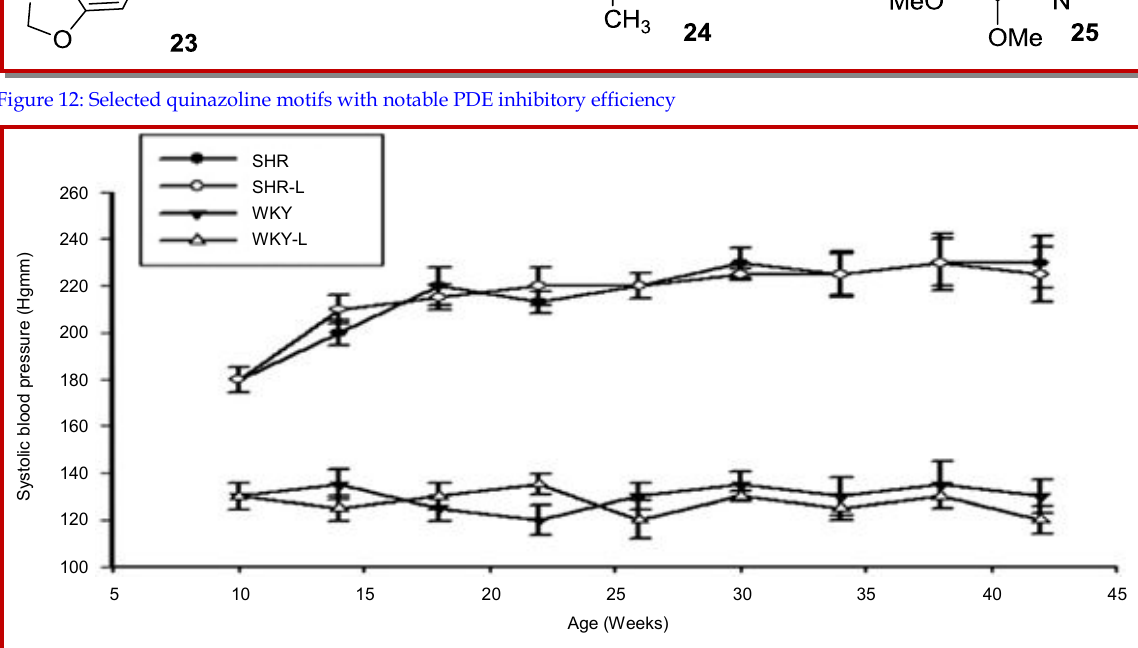
Figure 13: SBP values of normotensive (WKY-C, WKY-L) and hypertensive (SHR-C, SHR-L) rats. Values are means ± SEM. *p<0.05 (Magyar et al., 2014)